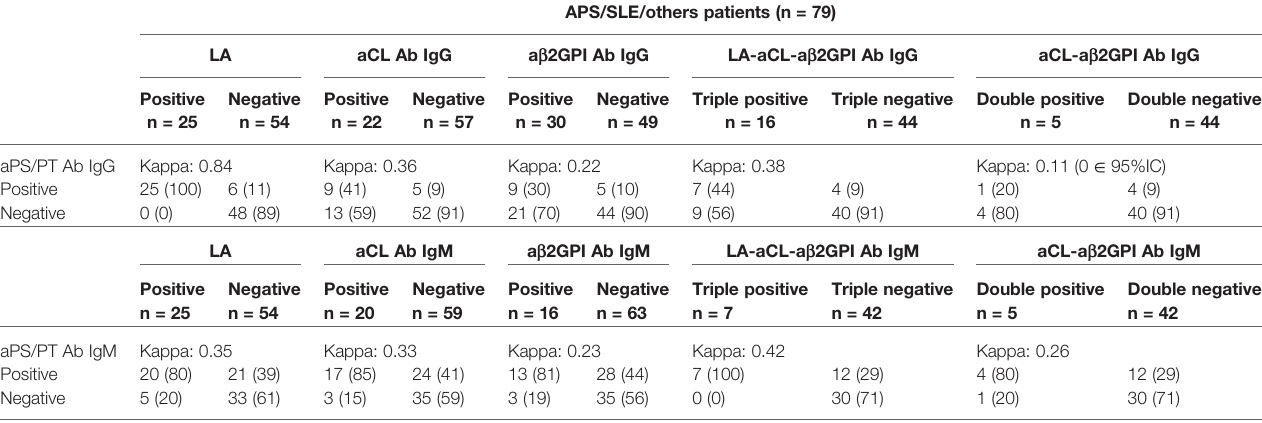
TABLE 3 | Prevalence of aPS/PT IgG and IgM antibodies compared to LA, aCL, and a b 2GPI at fi rst sample.